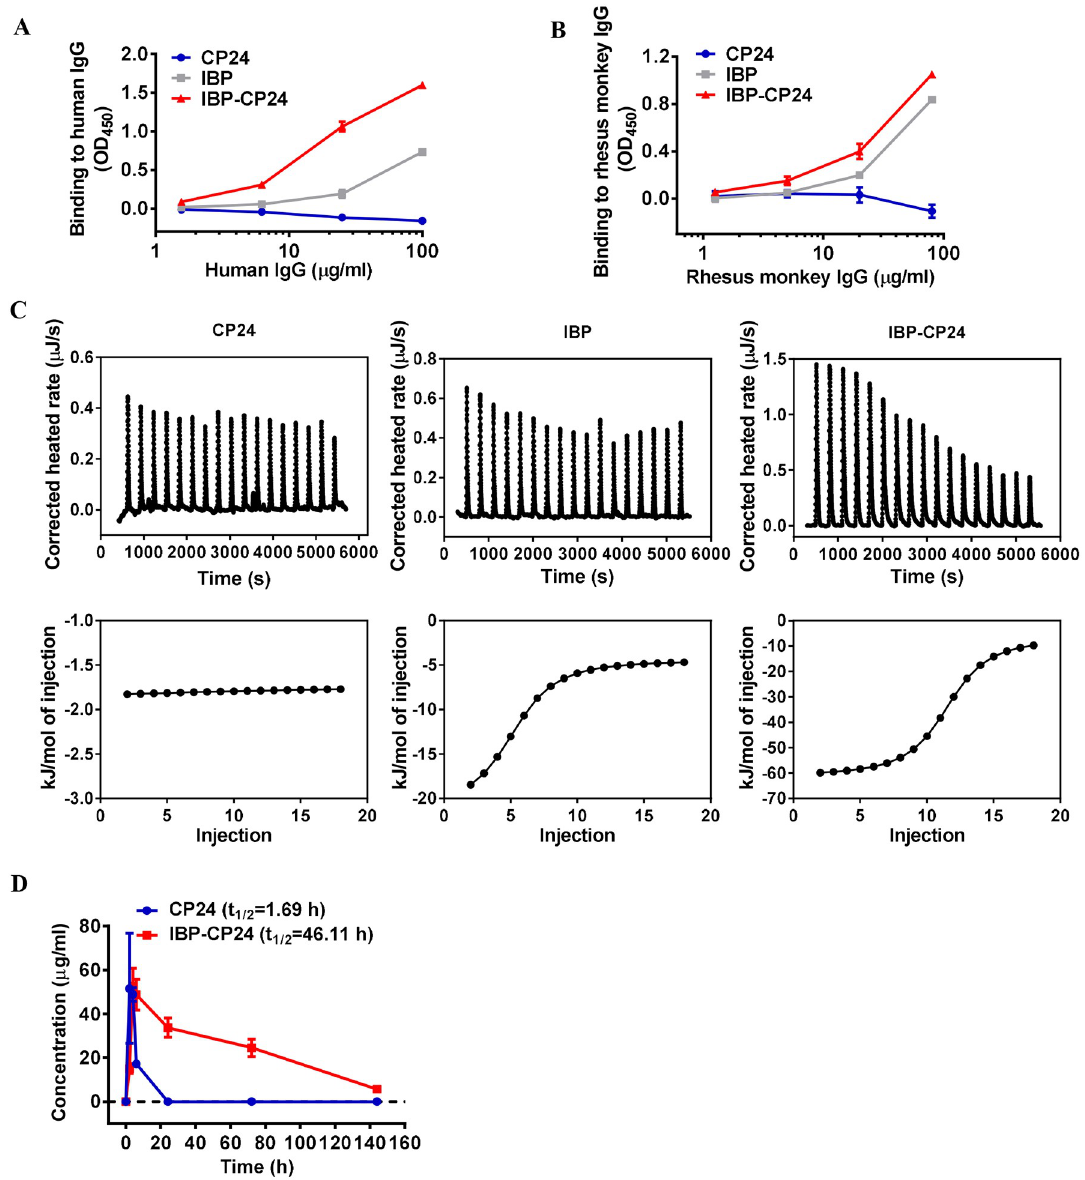
Fig 3. In vitro human and rhesus monkey IgG binding and in vivo pharmacokinetic studies of CP24 and IBP-CP24. (A) Binding affinity of CP24, IBP and IBP-CP24 to human IgG was determined by ELISA. (B) Binding affinity of CP24, IBP and IBP-CP24 to rhesus monkey IgG was measured by ELISA. Each sample was tested in triplicate and the data are presented as mean ± SD. (C) Binding affinity of CP24, IBP and IBP-CP24 to rhesus monkey IgG was evaluated by isothermal titration calorimetry (ITC) assay. The top panel showed the titration traces inhibitors solution injected into rhesus monkey IgG solution. The bottom panel showed the binding affinity of inhibitors to rhesus monkey IgG. (D) Plasma concentrations of CP24 and IBP-CP24 in vivo . Rhesus monkeys were administered intravenously with a single dose of 10 mg/kg CP24 (n = 2) or IBP-CP24 (n = 3). The concentrations were determined by sandwich ELISA. Each sample was tested in triplicate and data were presented as mean ± SD.